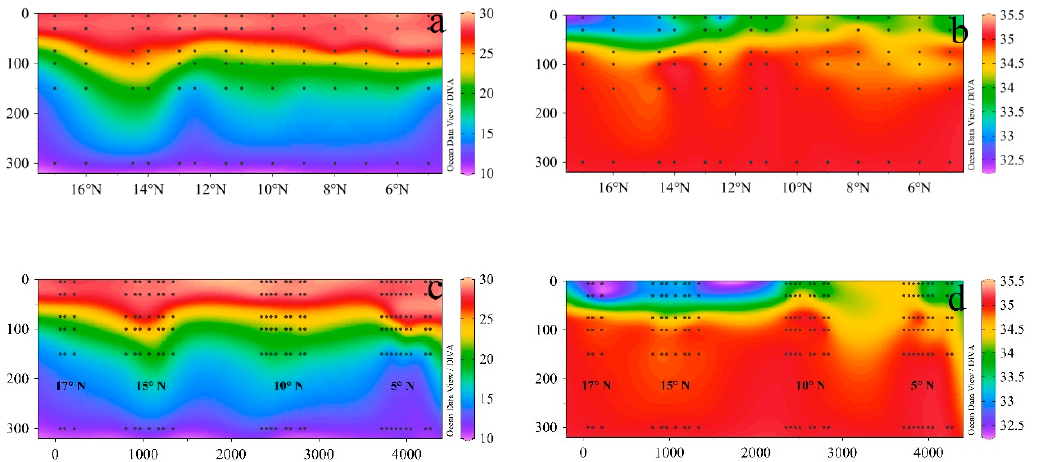
Figure 2. Vertical distribution of temperature (°C) and salinity (psu). ( a ) The vertical distribution of temperature along latitude. ( b ) The vertical distribution of salinity along latitude. ( c ) The vertical distribution of temperature in 17° N, 15° N, 10° N, and 5° N. ( d ) The vertical distribution of salinity in 17° N, 15° N, 10° N, and 5° N.